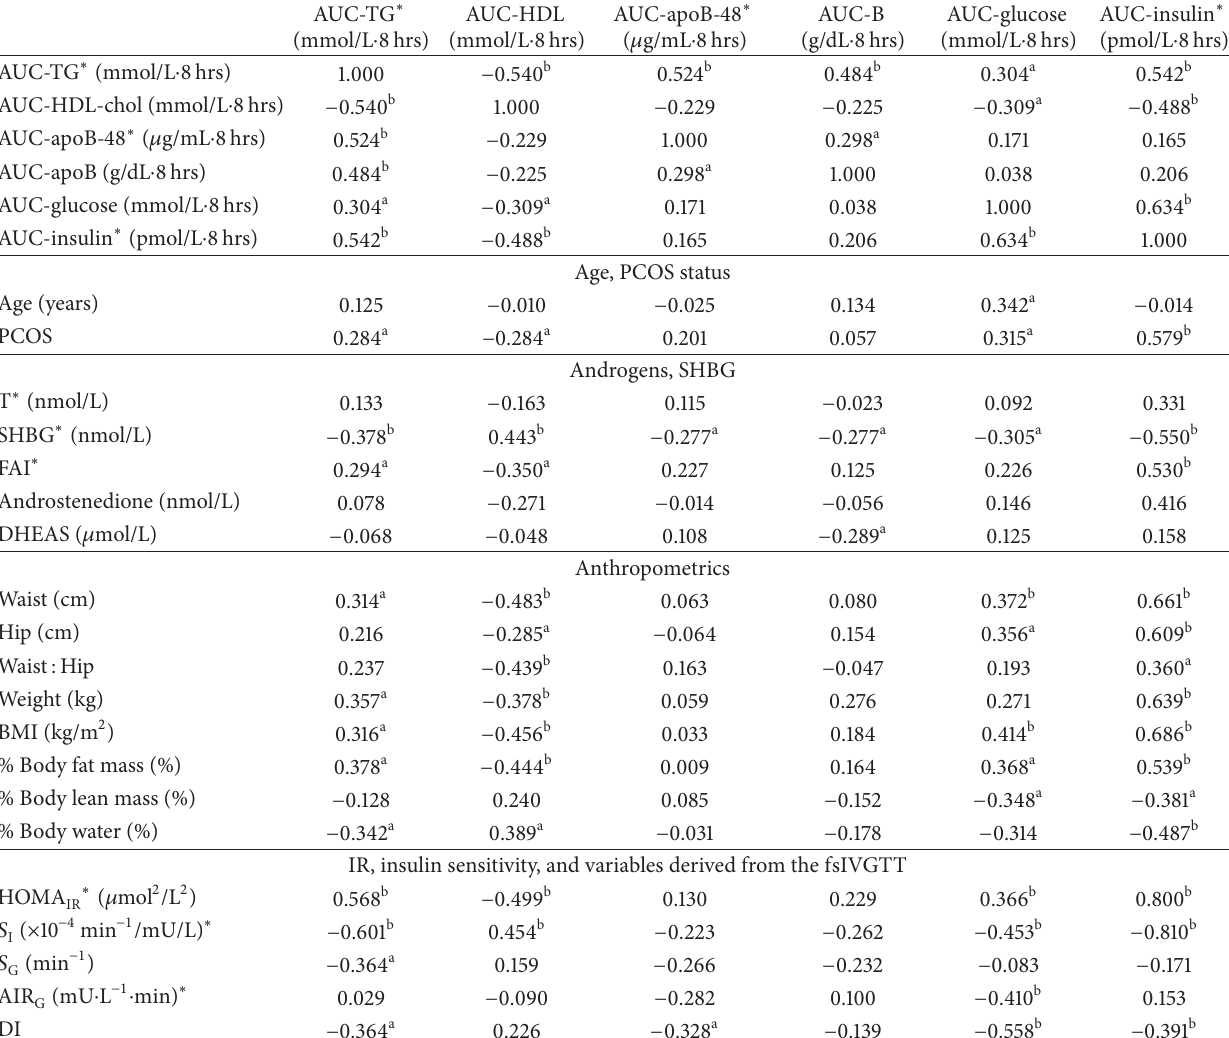
Table 6: Correlations between AUC-TG, AUC-HDL-chol, AUC-apoB-48, AUC-apoB, AUC-glucose, AUC-insulin, and other